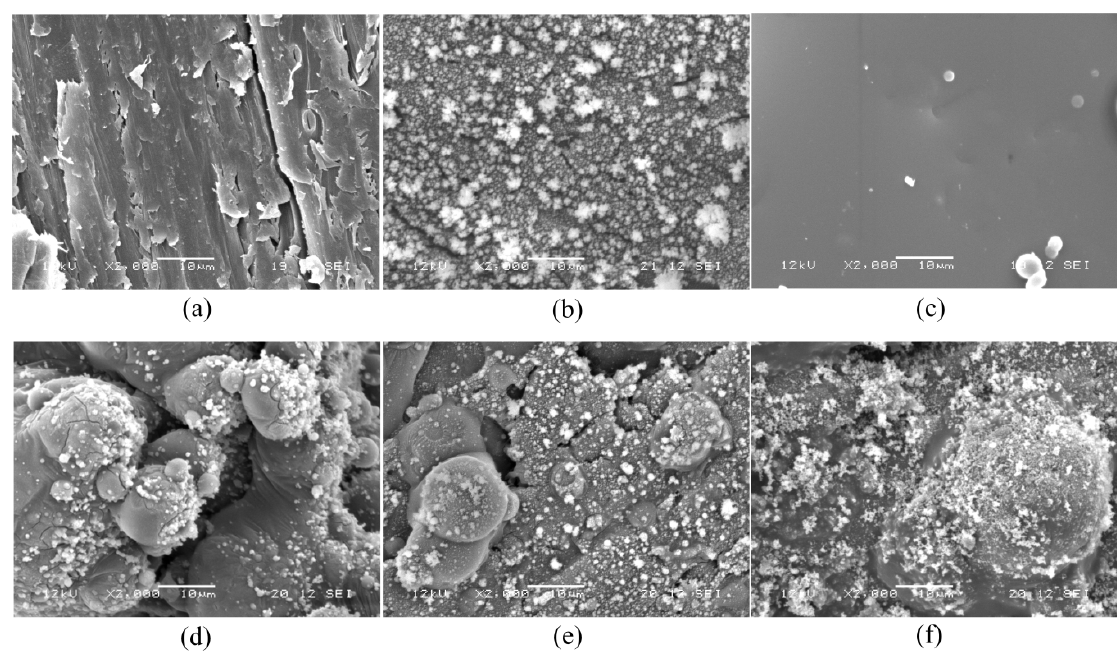
Figure 3. SEM-images with a magnification of 2,000× (scale bar 10 μ m): ( a ) uncoated wood beech; ( b ) TiO 2 film; ( c ) polyester thick film; ( d ) polyester/TiO 2 thick film; ( e ) polyester/TiO 2 thin film; ( f ) polyester/TiO 2 film via (PSP).